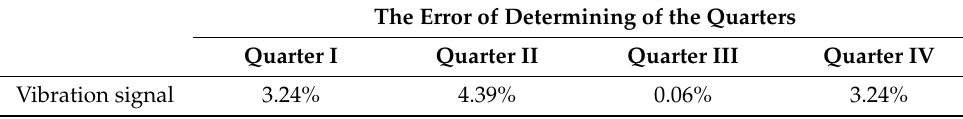
Table 5. The errors of determining the quarters (Figure 7b).